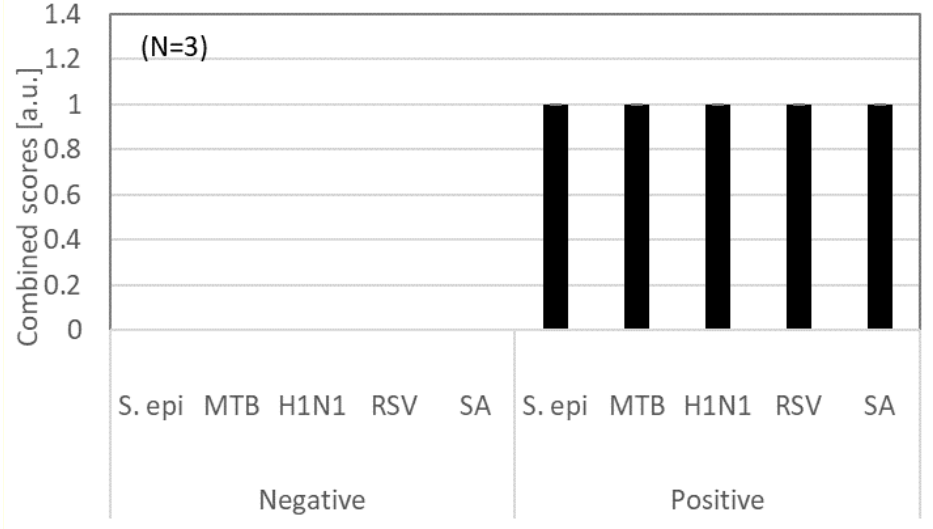
Figure 6. Combined scores for negative and positive nasal swab samples spiked with S. epidermidis, MTB, H1N1, RSV, and SA. The concentration of SARS-CoV-2 was 10 3 genome equivalents/mL. The bacterial concentrations of S. epidermidis , MTB, and S.a were 10 6 CFU/mL. The viral concentrations of H1N1 and RSV were 10 8 genome equivalents mL (N=3).